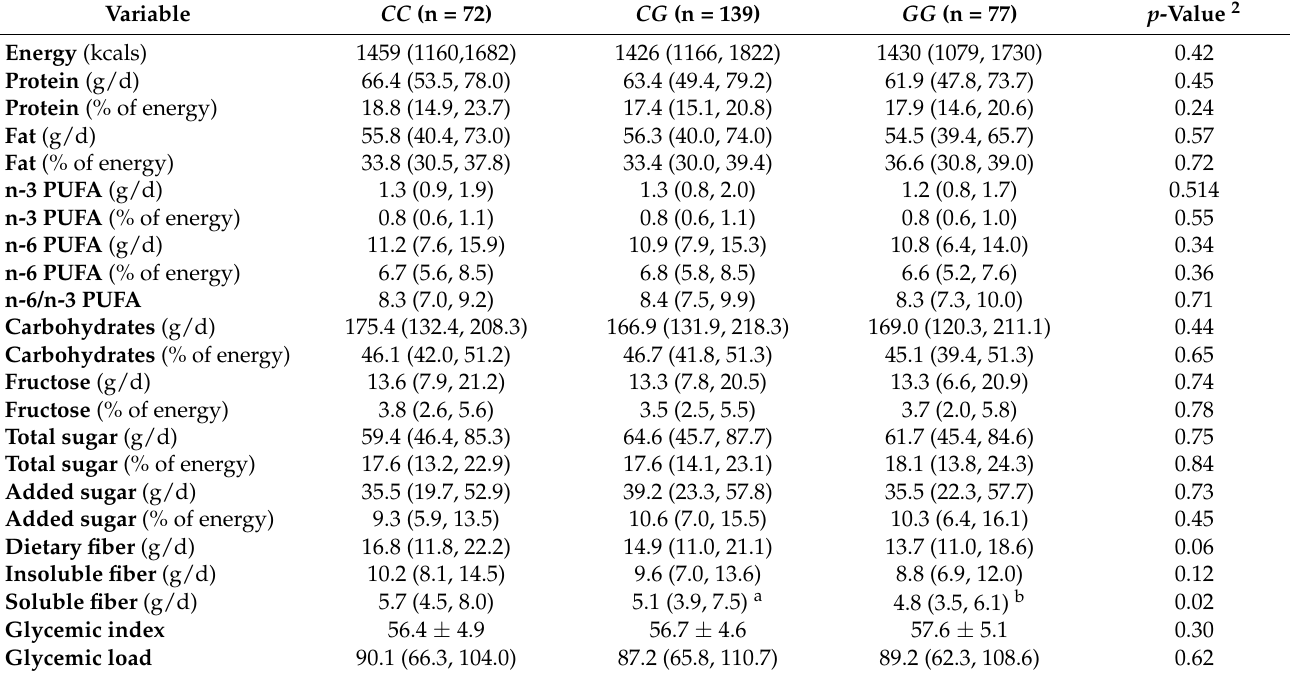
Table 2. Self-Reported Repeat 24-h Recall Dietary Intake of Mexican-Origin Participants by Genotype (n = 288) 1 . Variable